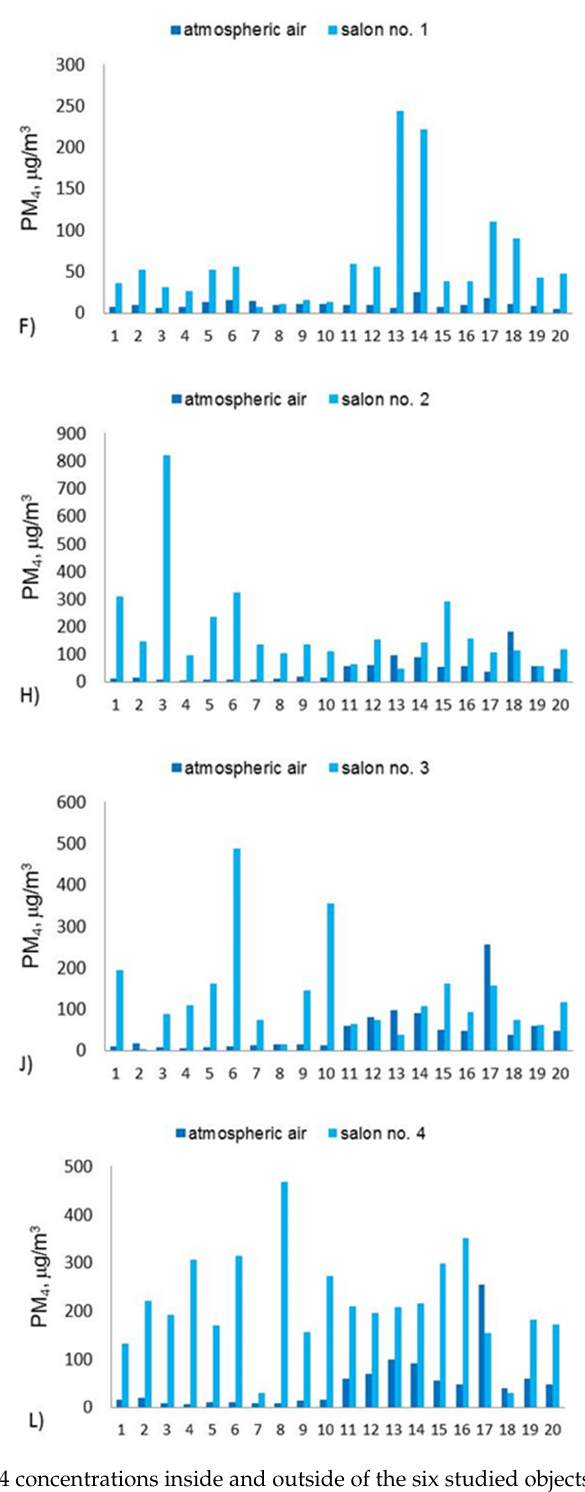
Figure 2. The 8 h course of TSP and PM4 concentrations inside and outside of the six studied objects in Bytom, in the period from 26 September 2016 to 31 October 2016. ( A , C , E , G , I , K ) show the 8-h concentrations of TSP in restaurant kitchen, printing house, beauty salon no. 1, beauty salon no.2, beauty salon no. 3 and beauty salon no. 4, respectively and in their outdoor background (atmospheric air). ( B , D , F , H , J , L ) show the 8-h concentrations of PM4 in restaurant kitchen, printing house, beauty salon no. 1, beauty salon no. 2, beauty salon no. 3 and beauty salon no. 4, respectively and in their outdoor background (atmospheric